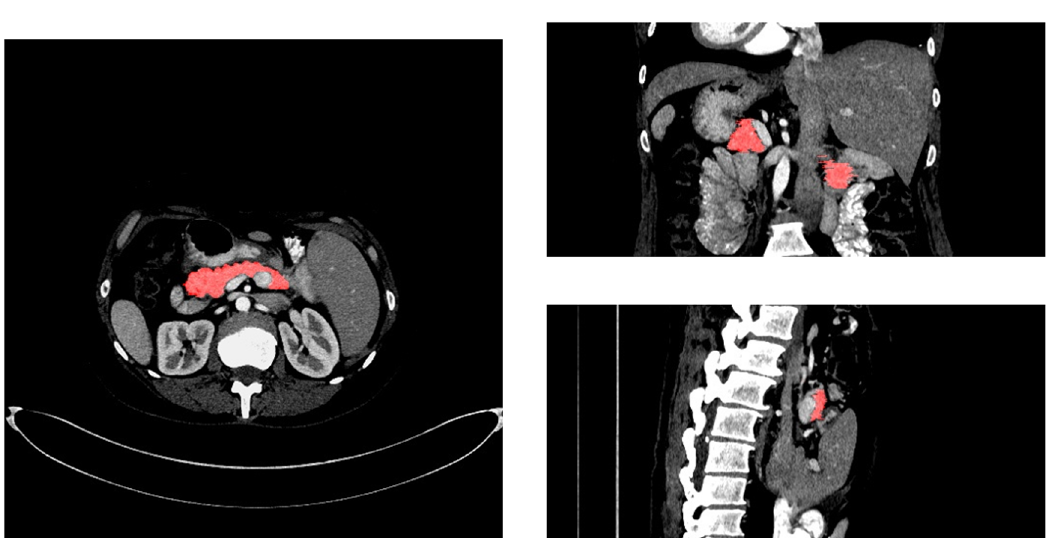
Fig 1. Slices from three different viewpoints. Pancreas is highlighted in red and is a small organ with vague boundary and irregular shape.